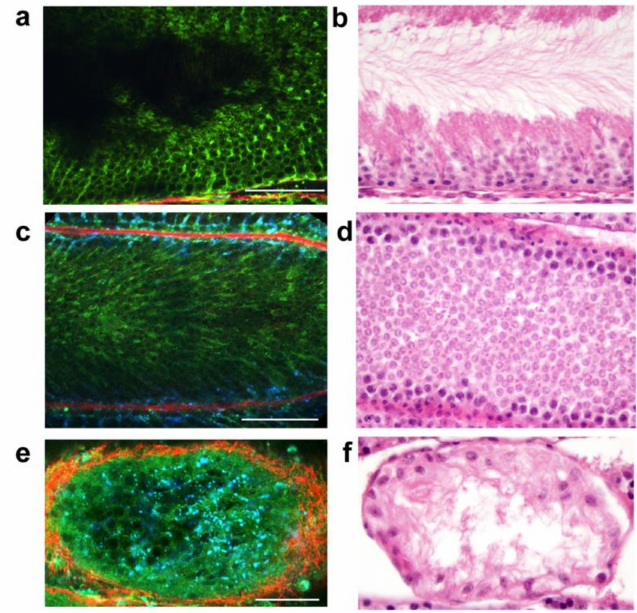
Figure 2. Varying seminiferous tubule histology patterns from rat testis procured using an ischemia hypothermia model (multiphoton microscopy panels ( a , c , e ); fixed in Bouin’s solution panels ( b , d , f ). Panels ( a , b ) show seminiferous tubules with spermatogenesis. Panels ( c , d ) demonstrate tubules with maturation arrest. Panels ( e , f ) illustrate tubules with a Sertoli cell only pattern. (Reprinted with permission from [49]. Copyright 2011 American Urological